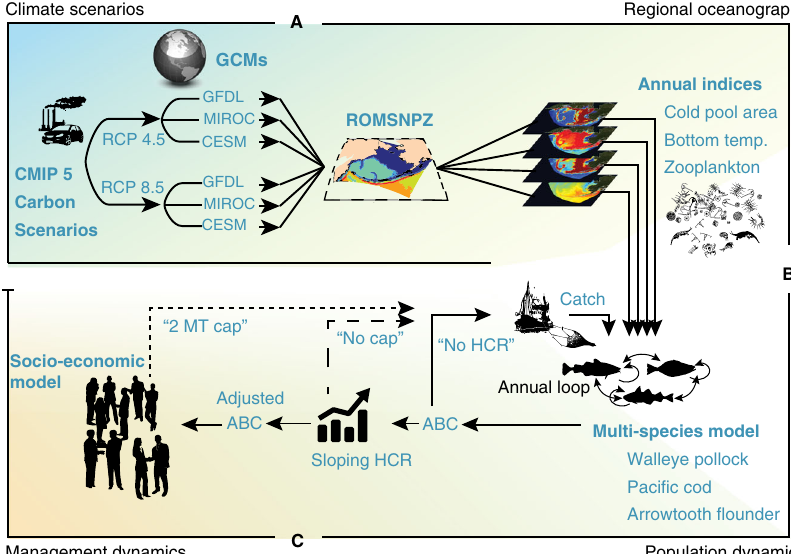
Fig. 1 Model coupling framework. a Regional downscaling where three global climate models driven by the IPCC AR5 CMIP5 emission scenarios determine boundary conditions of the coupled ROMSNPZ high resolution oceanographic model for the Bering Sea, AK. b Biological downscaling of annual indices from the ROMSNPZ were used to drive thermal parameters in the CEATTLE model (i.e., weight-at-age and predation) as well as climate-enhanced spawner-recruitment relationships. c Annual harvest recommendations (ABC) from the assessment model which were translated into annual catch using the ATTACH social-economic model of the effect of EBFM policies on